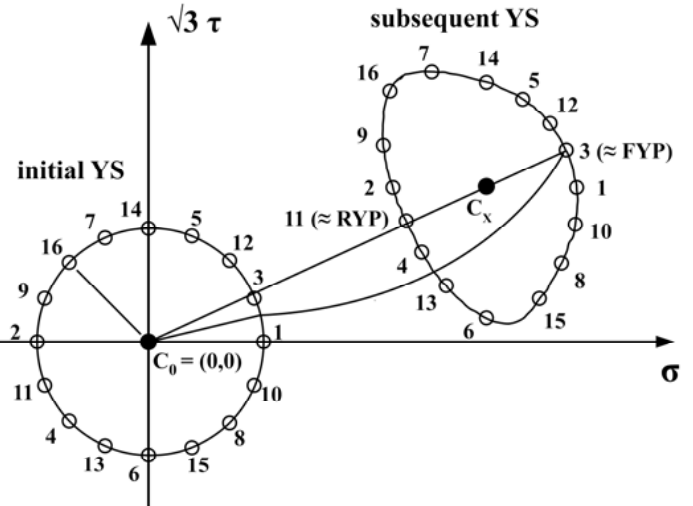
Figure 3. Schematic drawing of an initial and a subsequent YS. Probing systems composed of series of 16 probes.